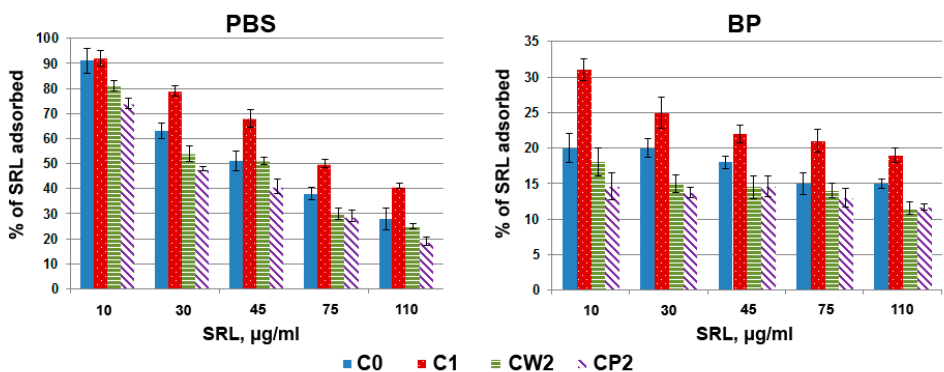
Figure 5. The adsorption of SRL onto different fractions of AC. Solutions of SRL with various concentrations in 0.5 mL PBS or BP were incubated with 33 µg of AC for 15 h. The percentage of adsorbed SRL relative to the initial concentration in the solution was calculated.